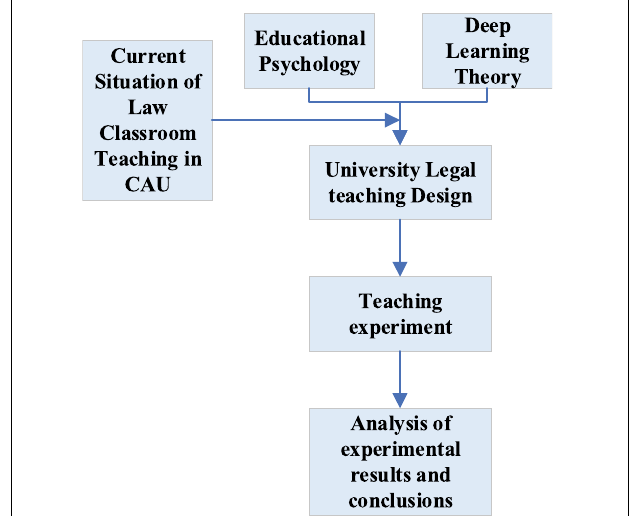
FIGURE 1 | Organization structure of this